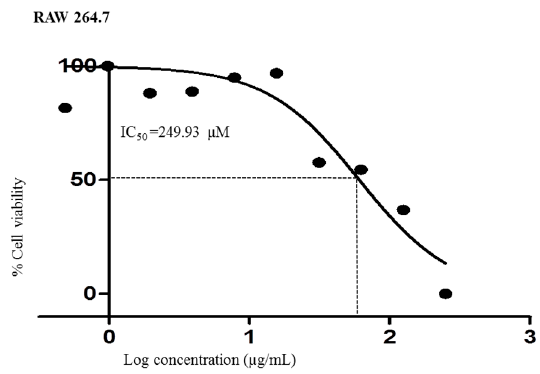
Figure 4. Dose-response curve for compound 1: IC 50 value was calculated from the cell viability analysis in normal mouse macrophages (RAW 264.7). A selectivity index (SI) of 8.70 was obtained by calculating the ratio of the IC 50 in RAW 264.7 cells to that in T. brucei brucei cells.